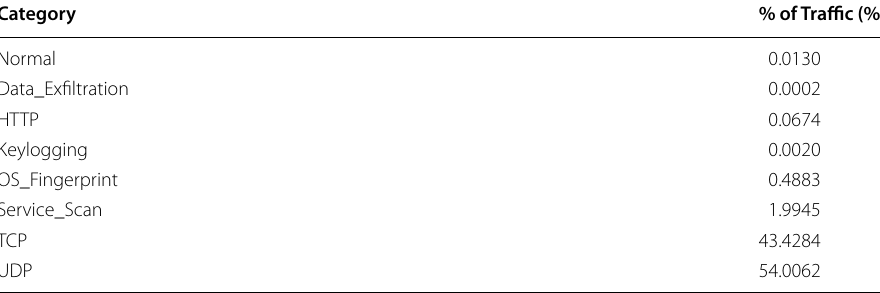
Table 7 % of Normal and Attack Traffic in UNSW-NB18